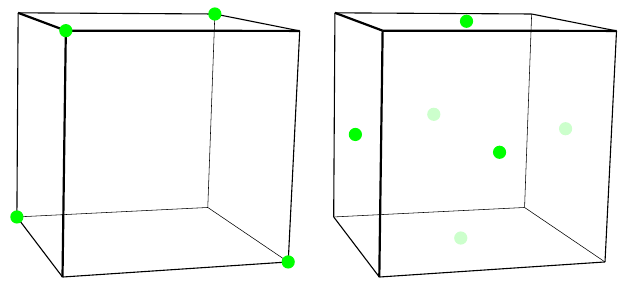
Figure A2. Left: Placement of 4 responders (3-D case) Right: Placement of 6 responders (3-D